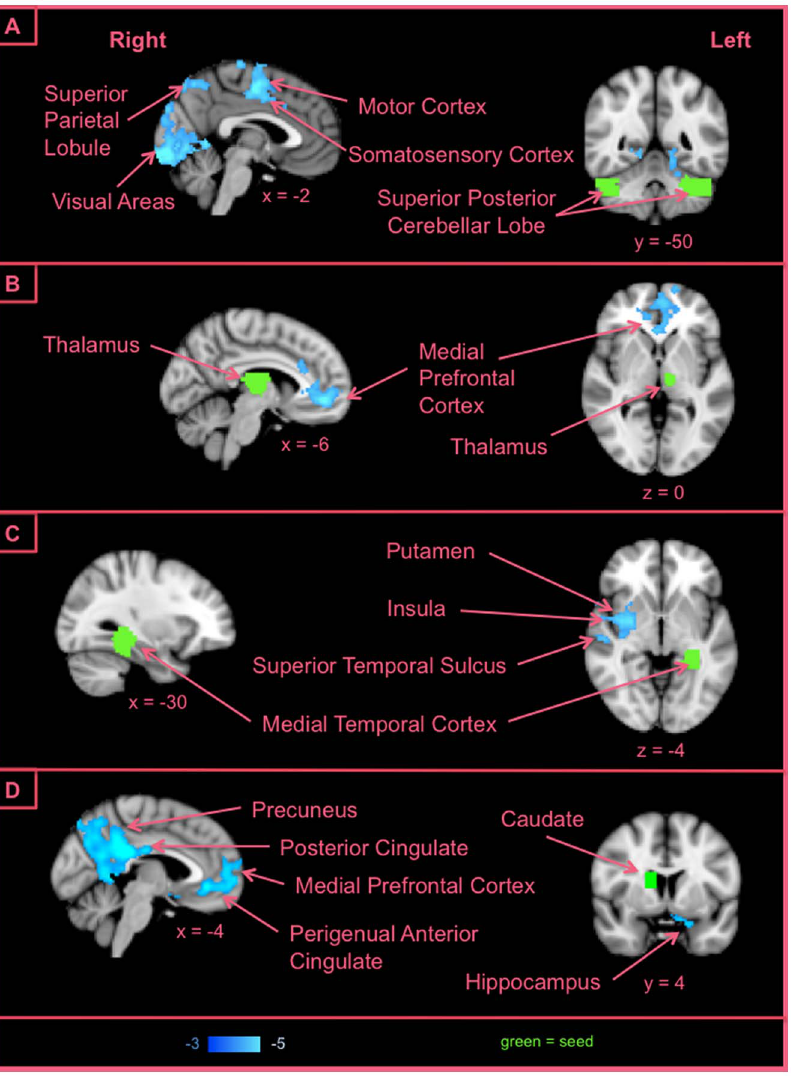
Figure 7. Examples of connections correlated with Positive Affect. We detected a large network that was negatively correlated to the PA score; greater connectivity within this network was observed to correlate with lower PA.